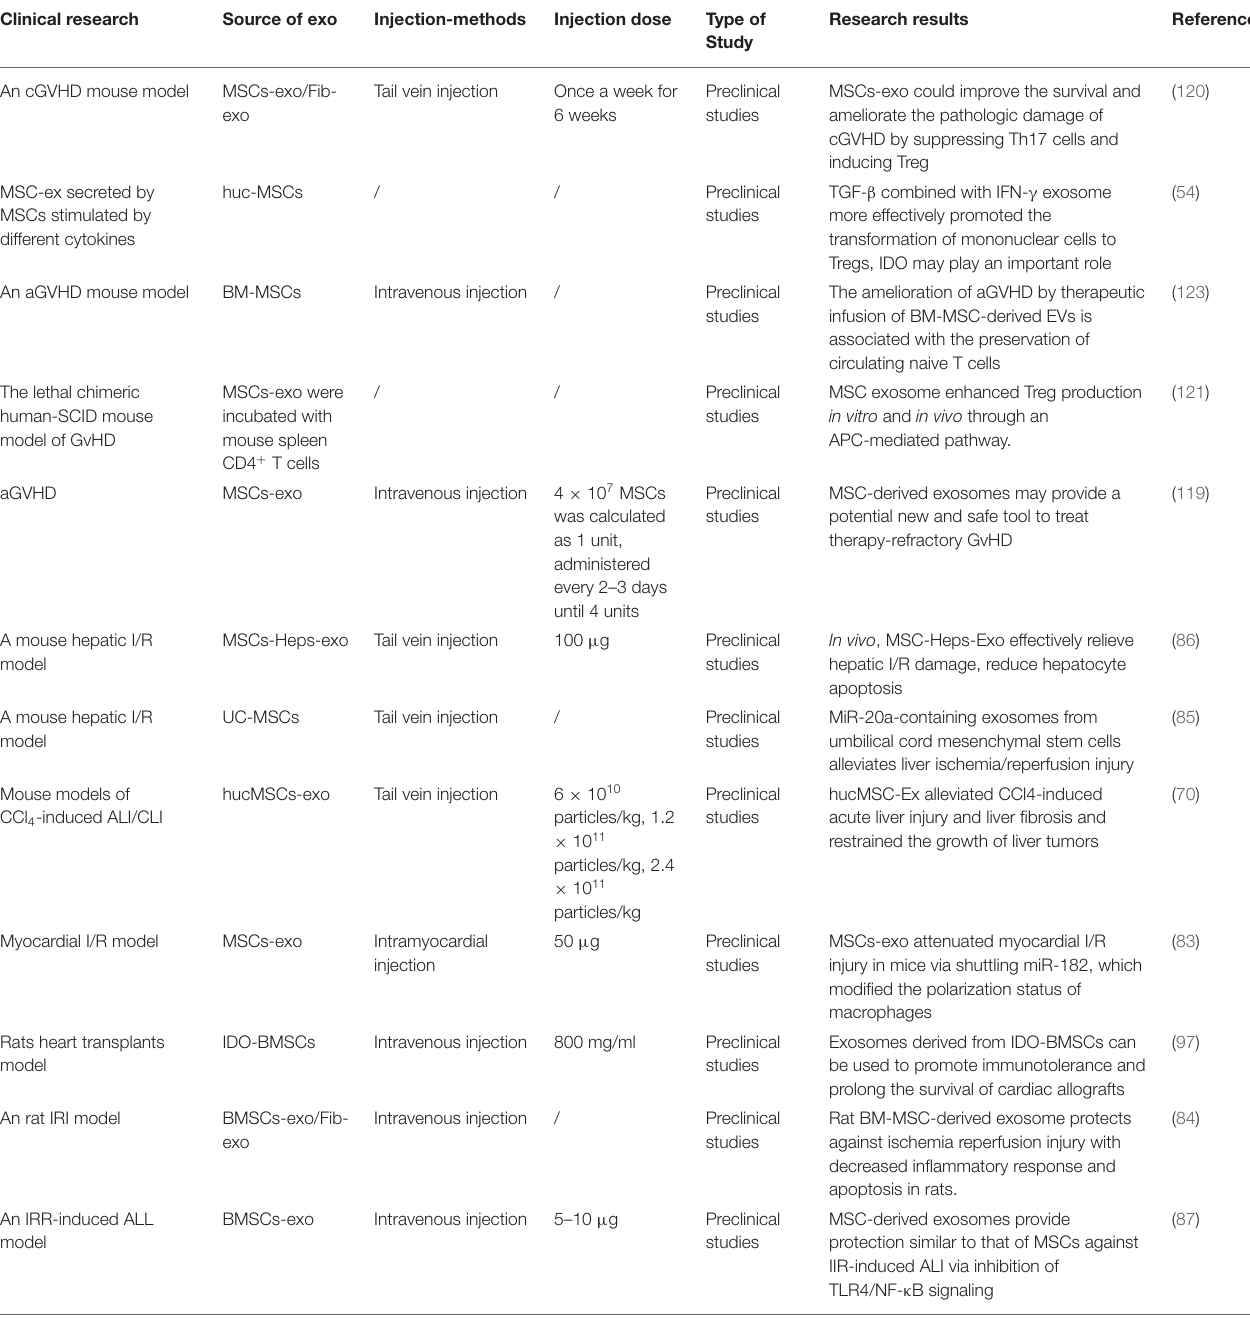
TABLE 2 | The application of MSC-derived exosomes in GvHD and